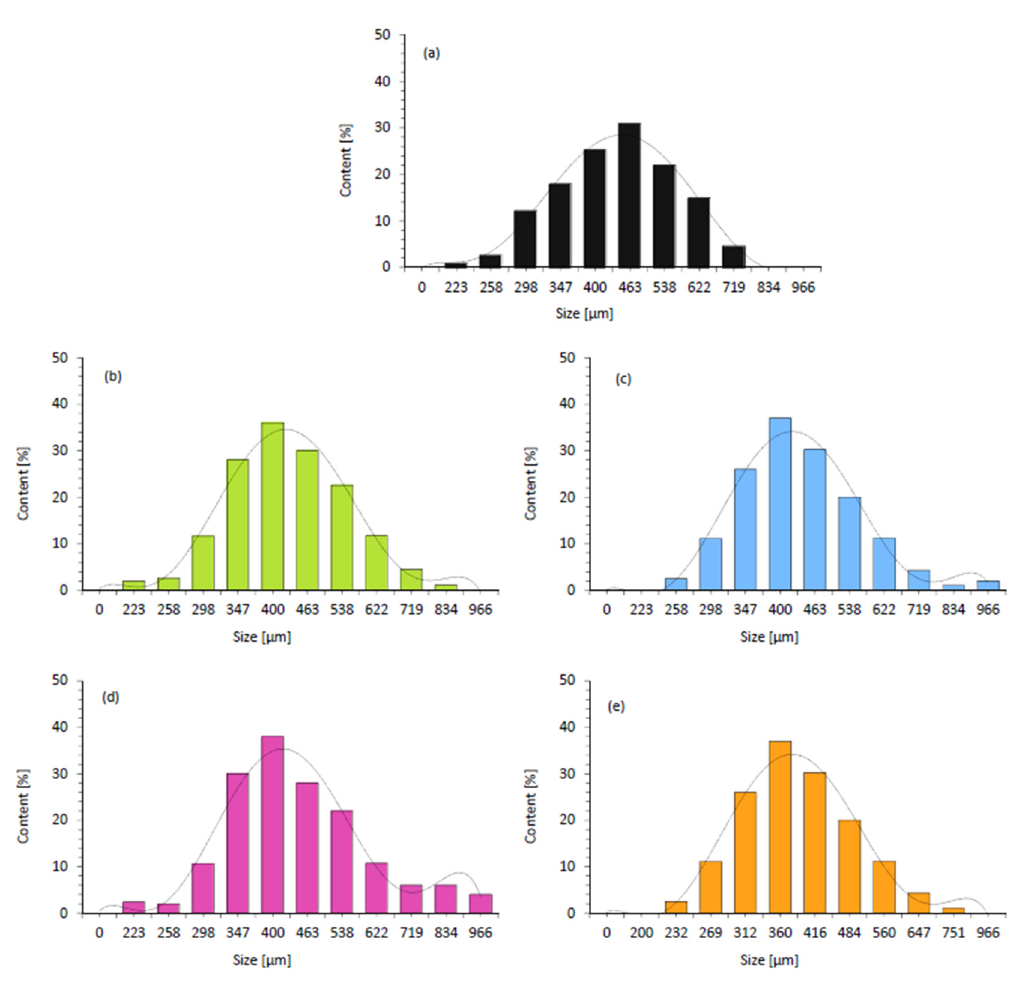
Figure 5. Call size distribution of ( a ) PUR_0, ( b ) PUR_WS, ( c ) PUR_WS/P, ( d ) PUR_WS/MMT and ( e ) PUR_WS/HL.